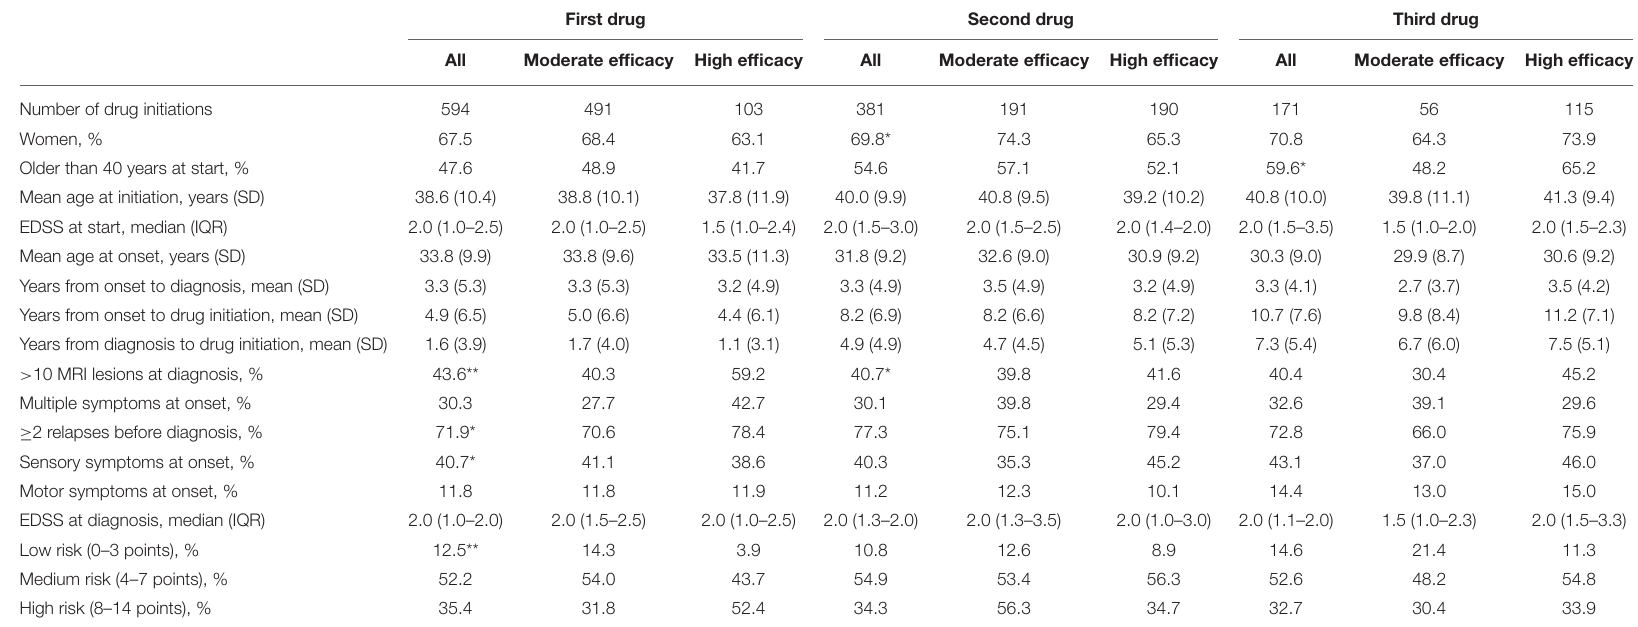
TABLE 3 | Demographics of study population. First drug Second drug Third drug All Moderate efficacy High efficacy All Moderate efficacy High efficacy All Moderate efficacy High